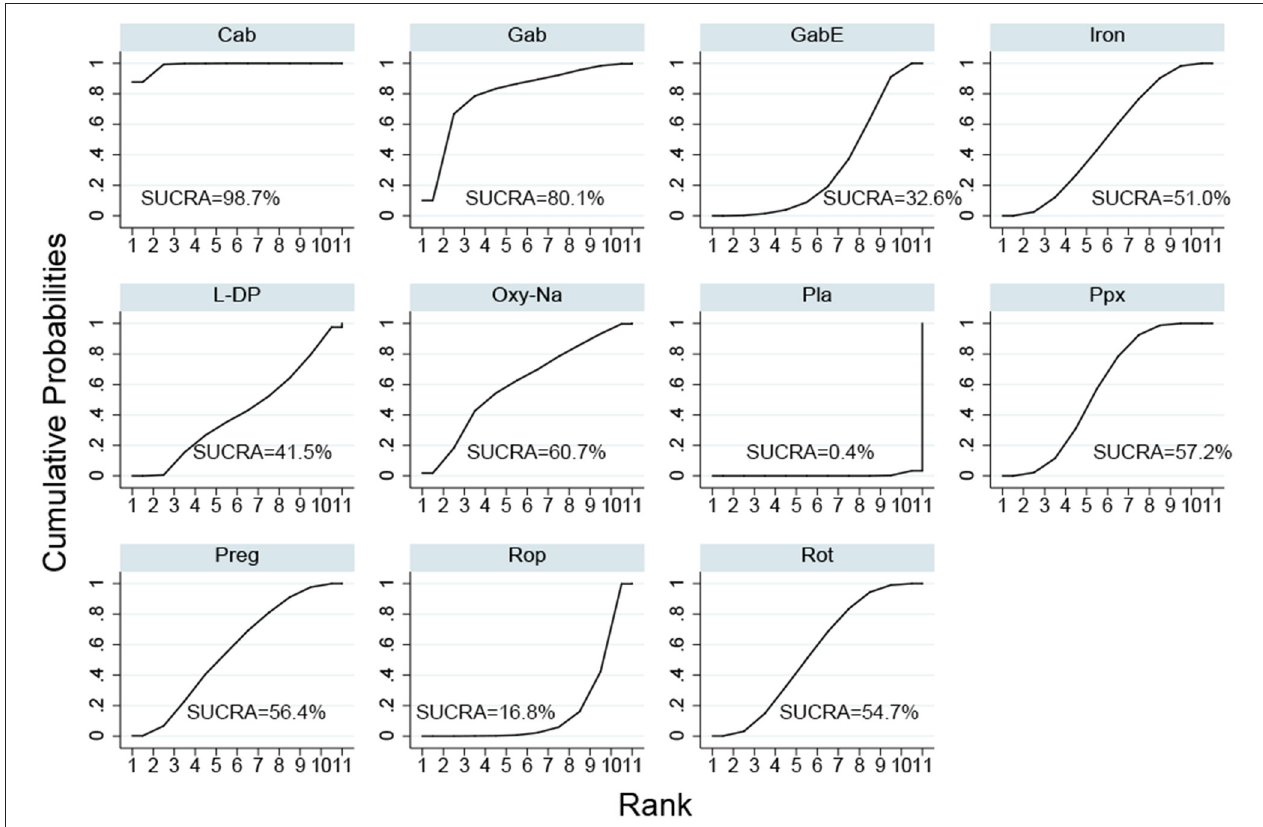
FIGURE 4 | Surface under the cumulative ranking curve (SUCRA) of all included drugs. (Gab, Gabapentin; GabE, Gabapentin enacarbil; L-DP, Levodopa; Rot, Rotigotine; Ppx, Pramipexole; Cab, Cabergoline; Rop, Ropinirole; Preg, Pregabalin; Oxy-Na, Oxycodone-naloxone; Pla,